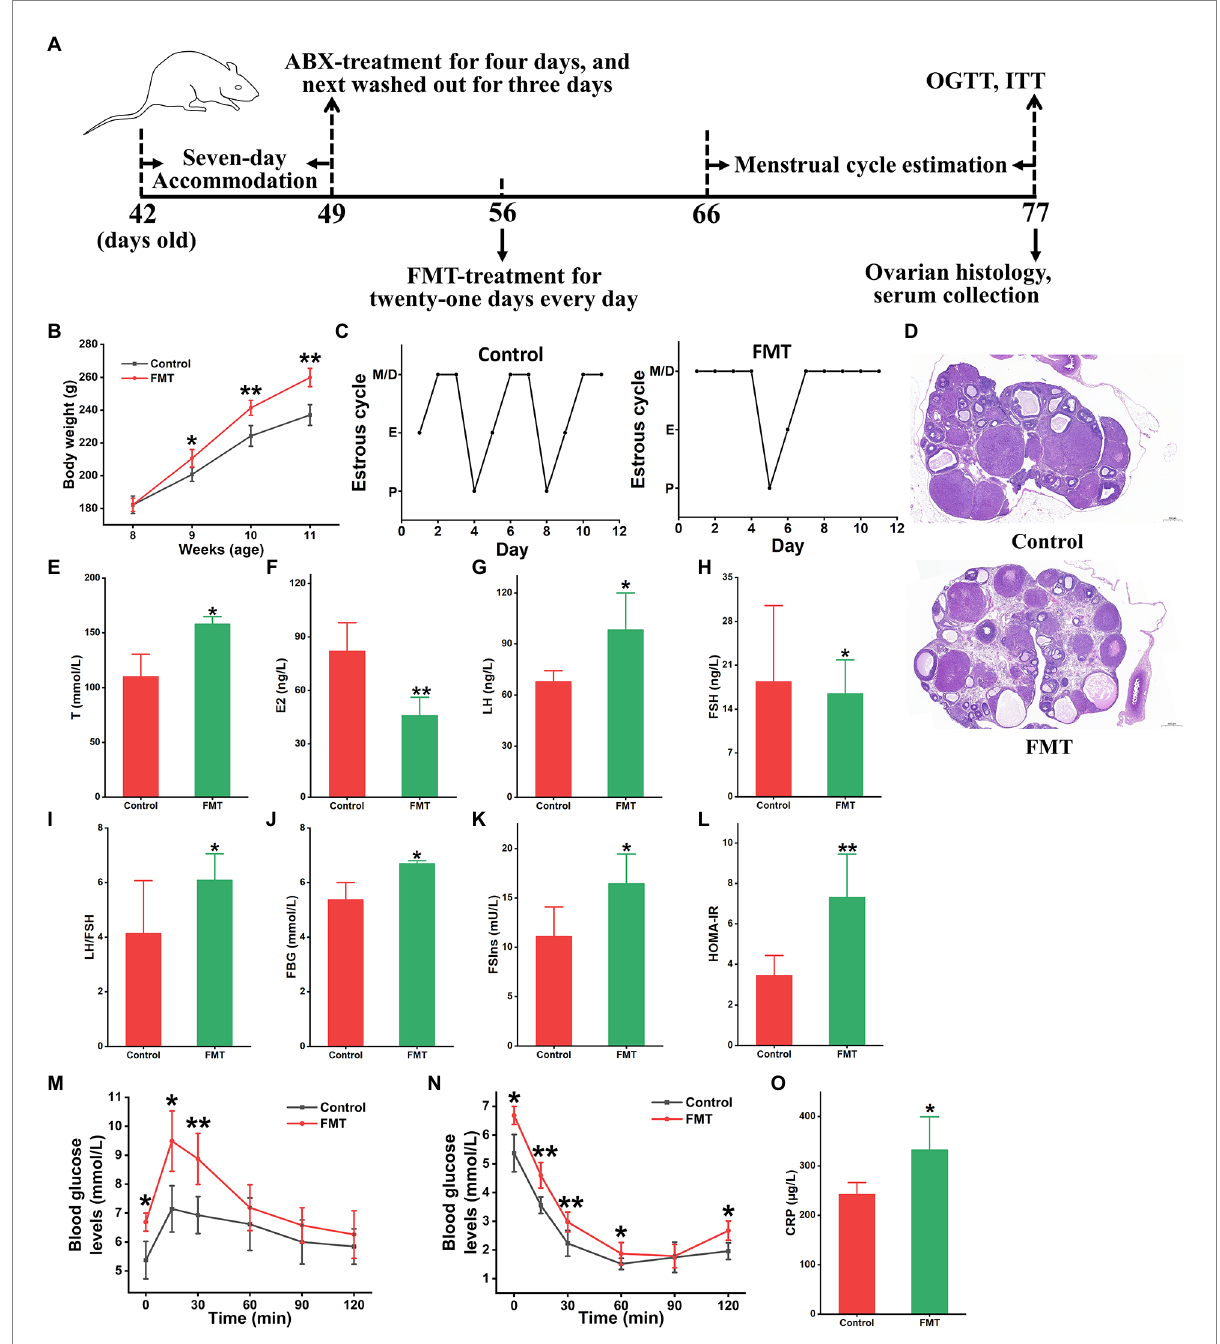
FIGURE 5 Gut microbiota from patients with PCOS induced disease-related phenotypes. (A) The schedule of this animal experiment; ABX, antibiotics (vancomycin, neomycin, metronidazole, and ampicillin); FMT, fecal microbiota transplantation; OGTT, oral glucose tolerance test; and ITT, insulin tolerance test. (B) Body weight change. (C) Menstrual cycle estimation. (D) Ovarian histopathology. Biochemical parameters include the levels of T (E) , E2 (F) , LH (G) , FSH (H) , LH/FSH (I) , FBG (J) , FSIns (K) , HOMA-IR (L) , OGTT (M) , ITT (N) , and CRP (O) in rats; T, testosterone; E2, estradiol; LH, luteinizing hormone; FSH, follicle-stimulating hormone; LH/FSH, the ratio of LH to FSH; FSG, fasting serum glucose; FSIns, fasting serum insulin; HOMA-IR, homeostasis model assessment of insulin resistance (HOMA-IR = FBG × FSIns/22.5); and CRP, C-reactive protein. n = eight rats in each group. Data are shown as mean ± standard deviation. Difference is compared by one-way ANOVA followed by Tukey’s post-hoc test. * represents the comparison between FMT and control groups ( * p < 0.05, ** p <